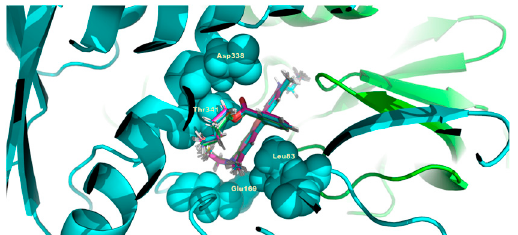
Figure 9. C4R1 docked structures on human ATP synthase. The conditions are the same as in Figure 8 except that the α -subunit of ATP synthase is shown in turquoise and β -subunit of ATP is in light green. C4R1 molecule is locked in the center of the figure entrapped in the same pocket as for C2R1 organized by the same amino acid residues (L83, E169, D338, T341).